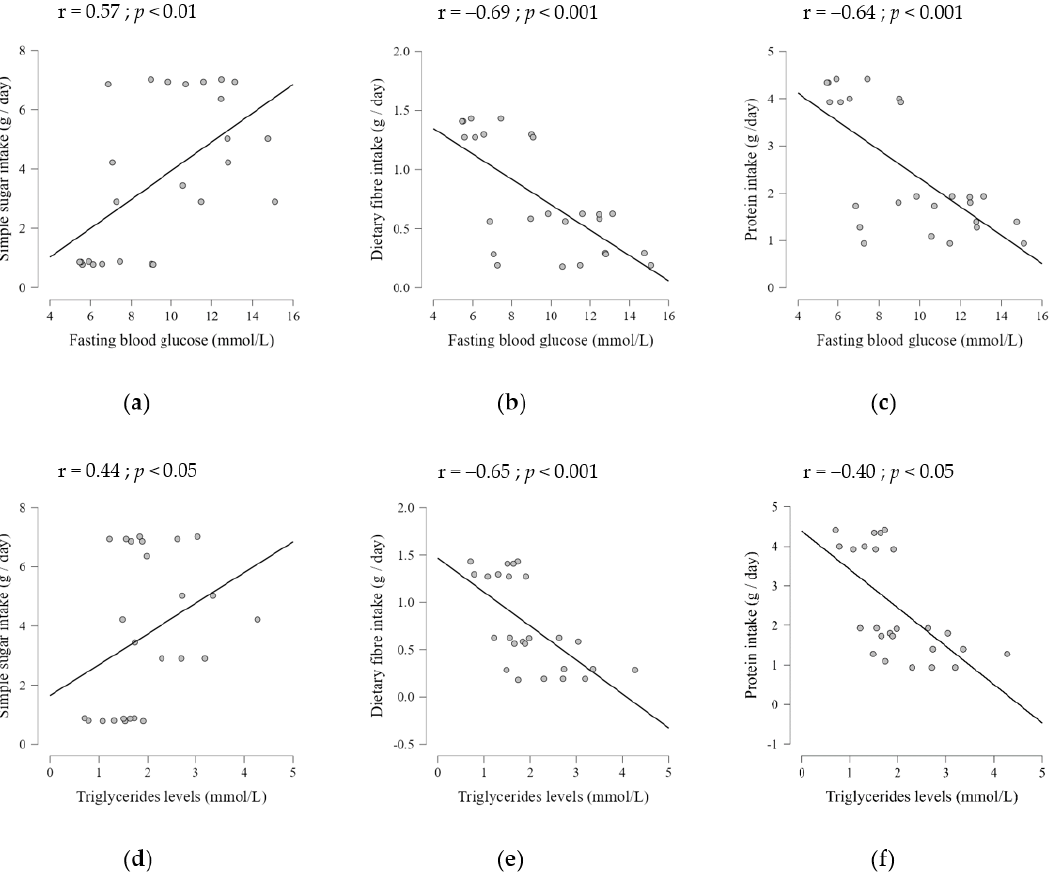
Figure 3. Correlation between nutrients intake and serum metabolic parameters. ( a ) Simple sugar intake had a positive correlation with fasting blood glucose, while ( b ) dietary fibre and ( c ) protein intakes had a negative correlation. ( d ) Simple sugar intake has positively correlated with triglycerides levels. A negative correlation was found between ( e ) dietary fibre and ( f ) protein intakes with triglycerides serum levels.